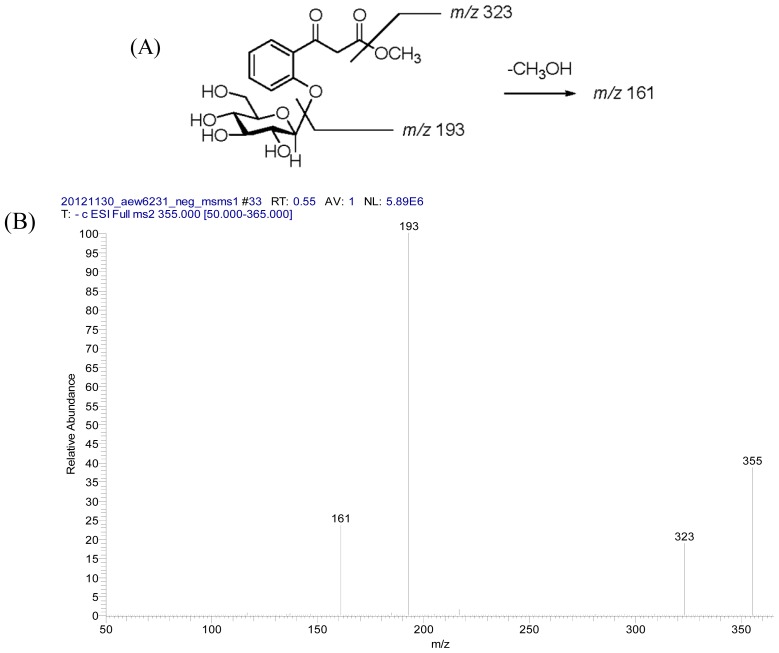
(A) Structure of 4 and main fragments under LC/MS/MS (negative ESI); (B) LC/MS/MS spectrum.